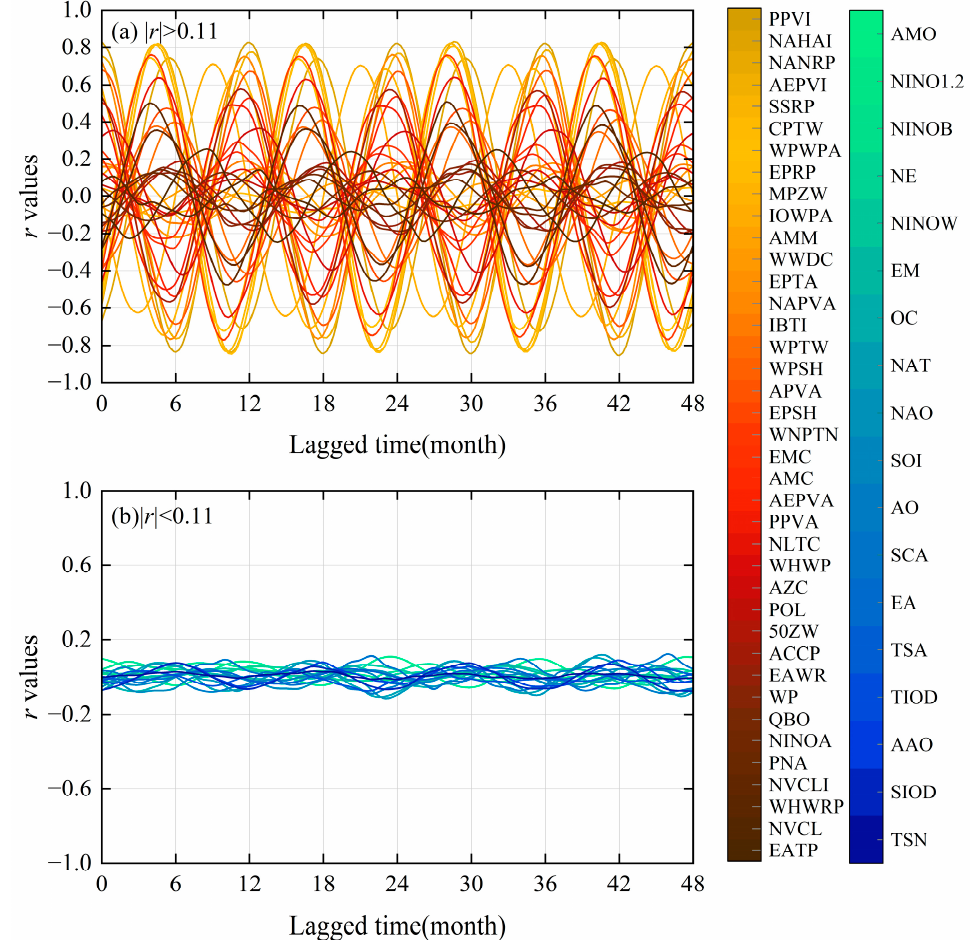
Figure 4. The variations of r values between the monthly D and the selected 57 circulation indices at site no. 52118 when the lagged months ranged from 0 to 48 months.